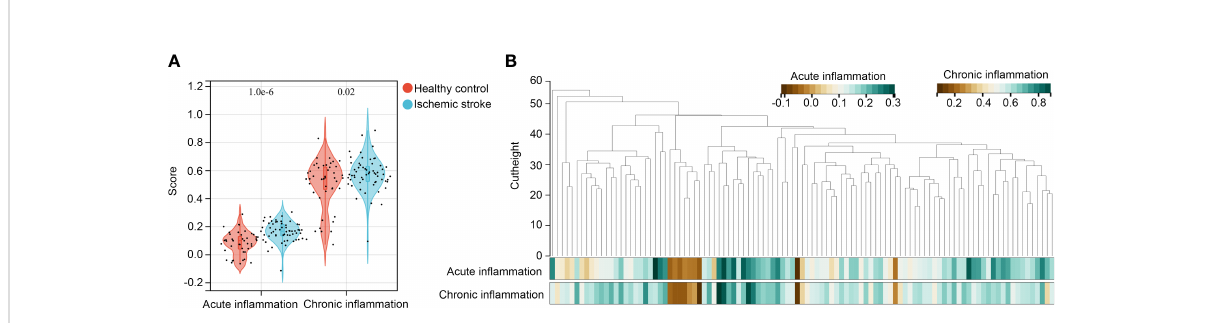
FIGURE 2 Identi fi cation of modules associated with acute and chronic in fl ammation scores (A) ssGSEA was performed to determine acute and chronic in fl ammation scores in patients with IS and healthy controls; (B) WGCNA was performed to identify co-expressed gene modules in the gene expression data of peripheral blood specimens from patients with IS and healthy controls.